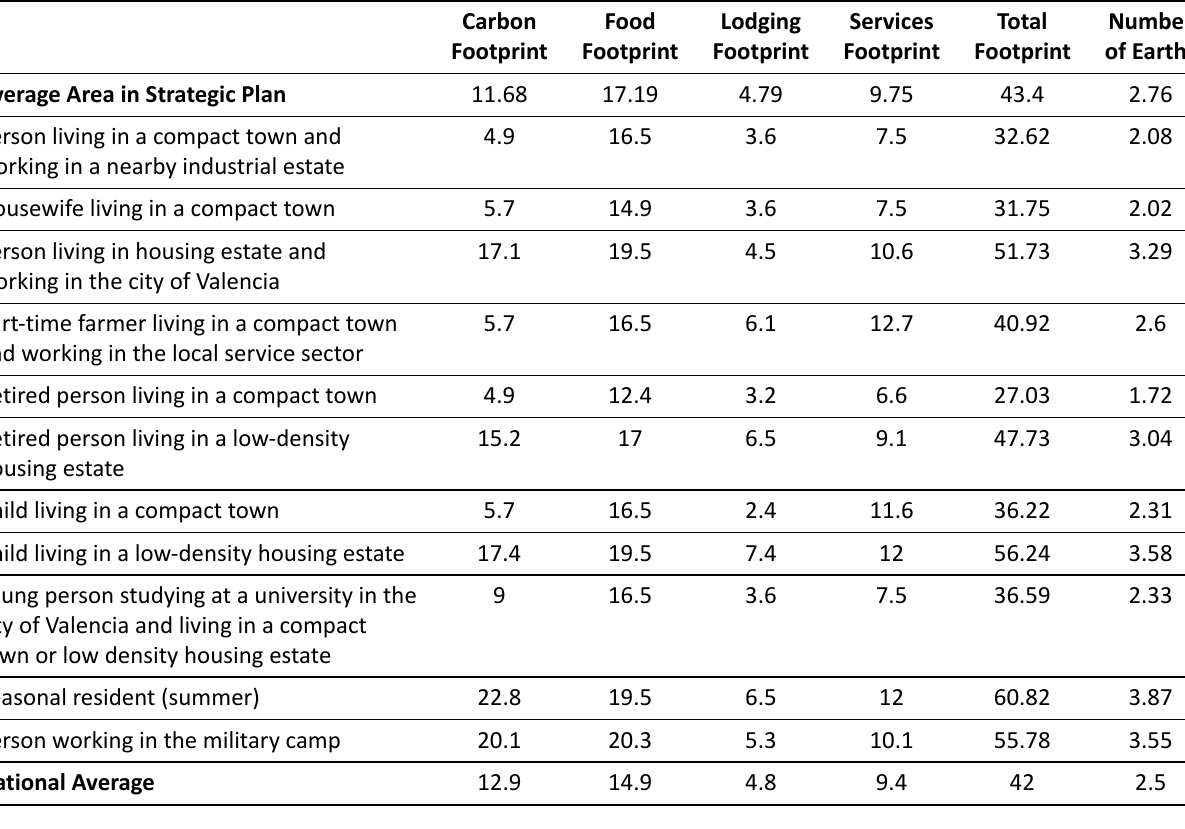
Table 2. Current EFs (global hectares) for different user/inhabitant profiles in the Sierra Calderona. Source: Galan